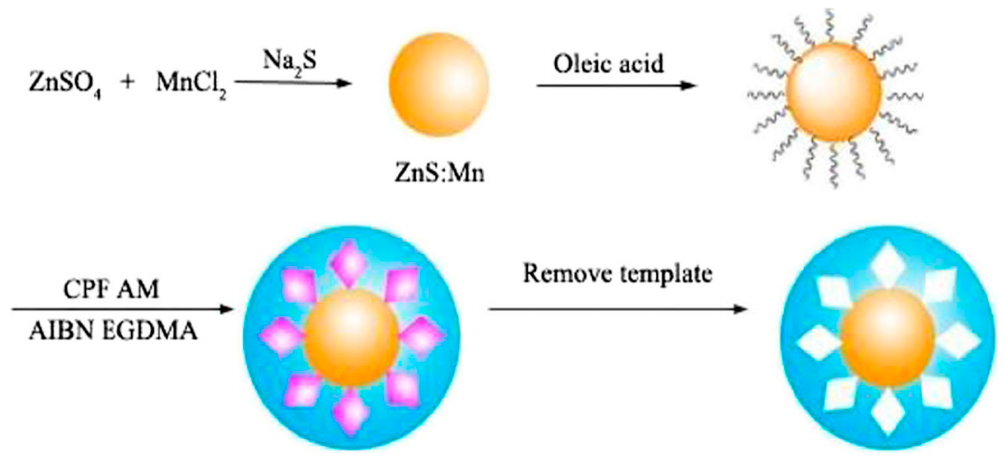
Figure 4. The preparation process of MIPs-coated quantum dots (QDs). Reprinted with permission from [63], copyright (2015) Springer Nature.